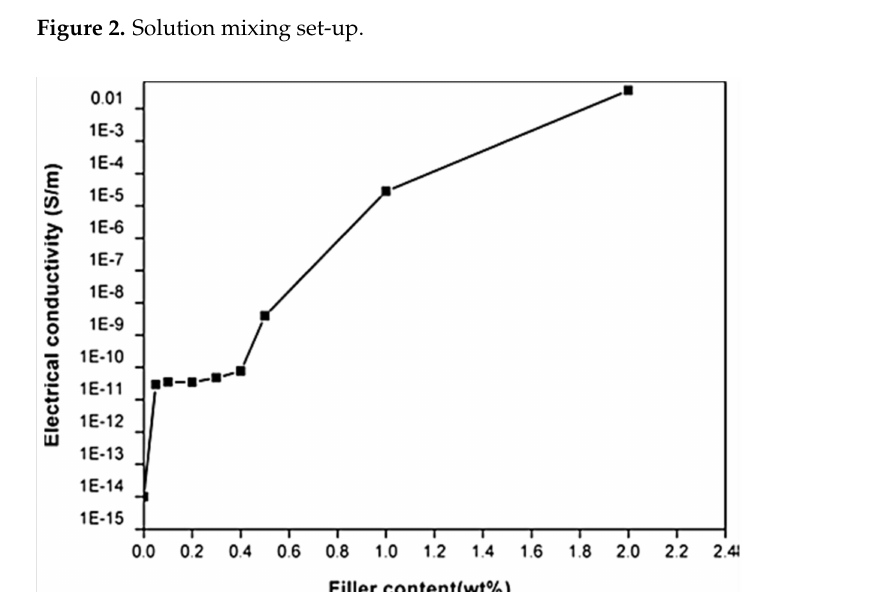
Figure 3. Electrical conductivities as a function of nanofiller content [31]. Reproduced with permission from